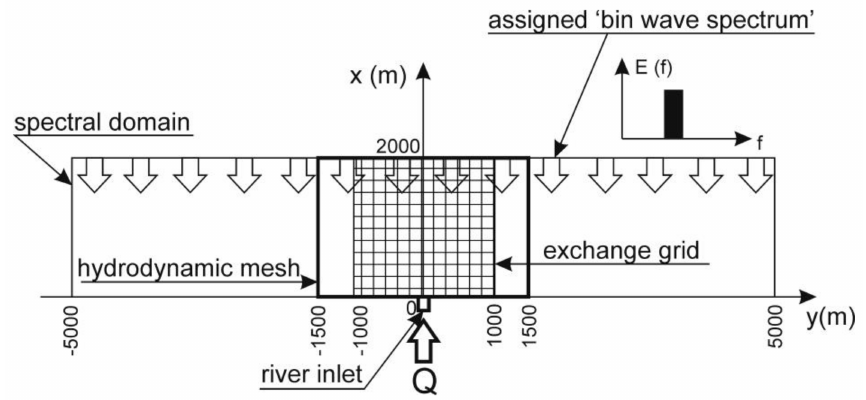
Figure 2. Computational grids. A “bin wave spectrum” is specified at the open sea boundary of the spectral domain, locating energy E(f) in one frequency bin closest to a corresponding assigned peak period. Q is the constant discharge set at x = − 200